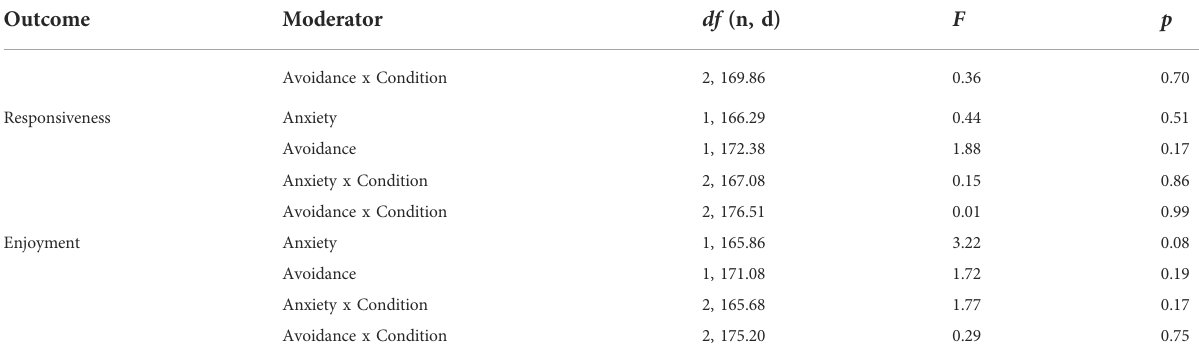
TABLE 3 ( Continued ) Moderator Analyses of Avatar Condition Effects: Personality and